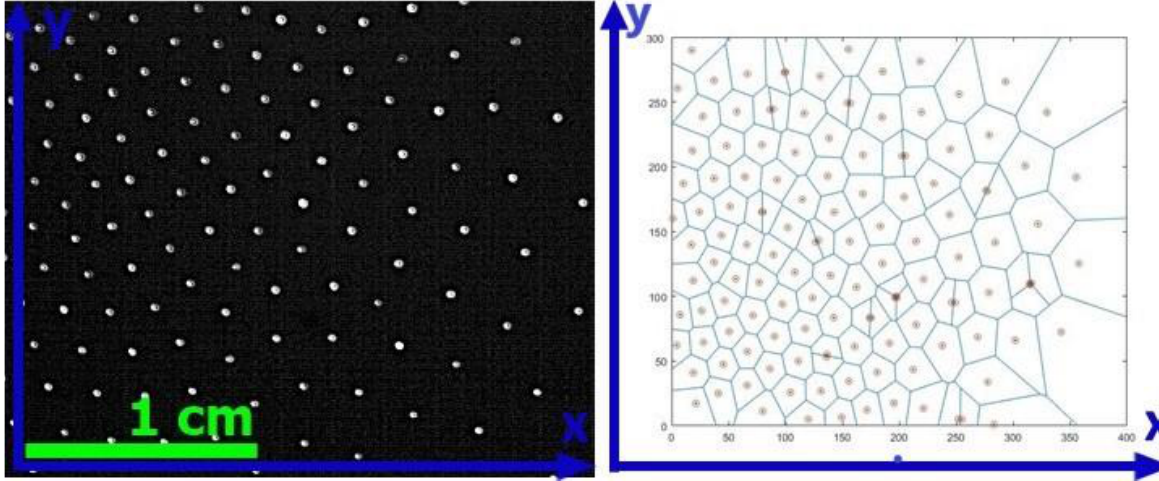
Figure 3. Voronoi diagram for top view of crystal layer in the area where the particles are stables.